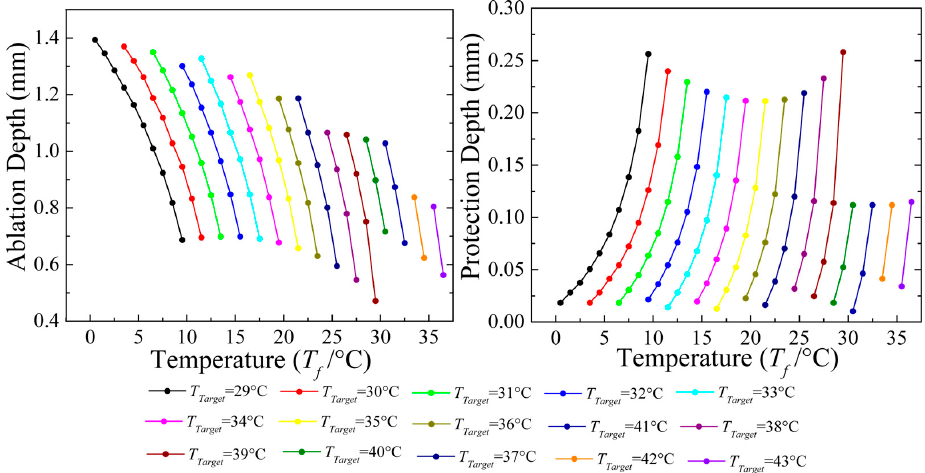
Figure 9. The relationships of the two parameters with the ablation depth ( left ) and the protection depth ( right ) in the feasible cases.